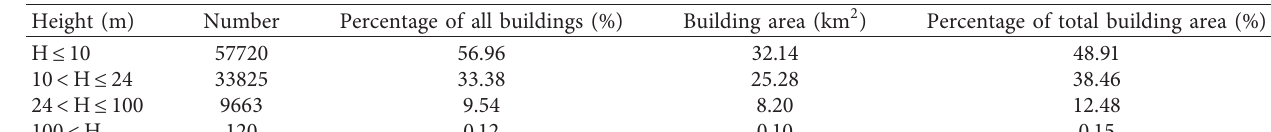
Figure 3: 3D spatial distribution of buildings. Table 2: Height of buildings in the study area.